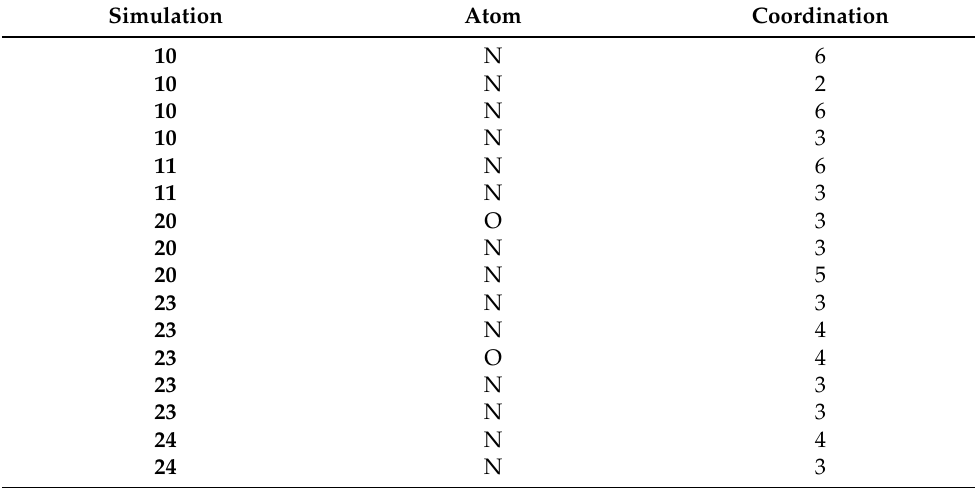
Figure 7. Simulation 23 , second reaction: also in the simulations containing oxygen, the oxygen-free reaction can be observed. In the actual case, bond breaking (N-N, H-H) and bond formation (N-H) occur almost simultaneously, with the H-H bond breaking being the fastest. Table 4. Final coordination numbers of the relevant nitrogen and oxygen atoms with lithium in the simulations where N-H formation was observed. In simulations 10 and 23 , two reaction events were monitored. High coordination numbers indicating nitride formation were observed preferably at low temperatures and in the systems without